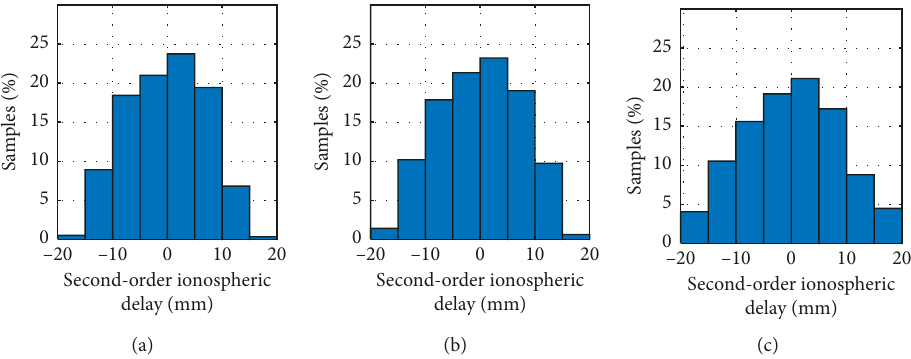
Figure 3: The statistics histograms of the second-order ionospheric delays at 15km (a), 45km (b), and 90km (c).